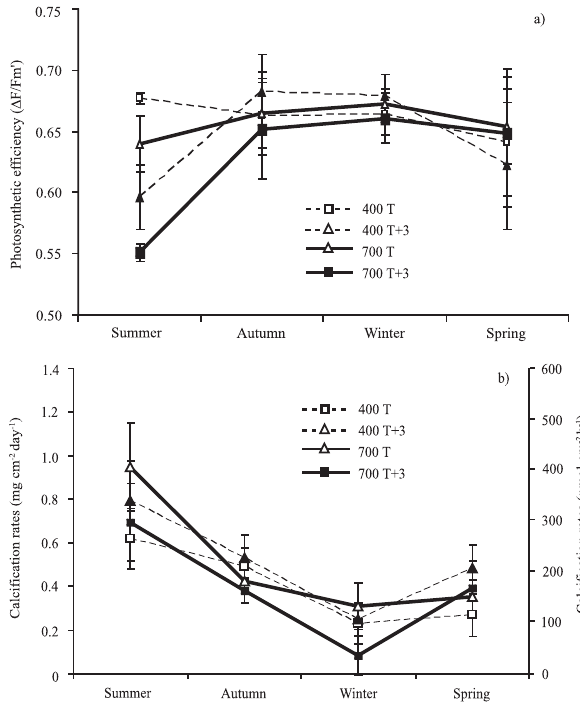
Fig. 4. Effective photosynthetic efficiency (a) and seasonal calci- fication rates (b) measured during the long-term experiment (one year) on Cladocora caespitosa exposed to the combined effect of normal (400µatm) and elevated (700µatm) p CO 2 , normal ( T ) and elevated ( T +3 ◦ C) temperatures. Data are mean ± s.e.m. (see Table 2 for degrees of